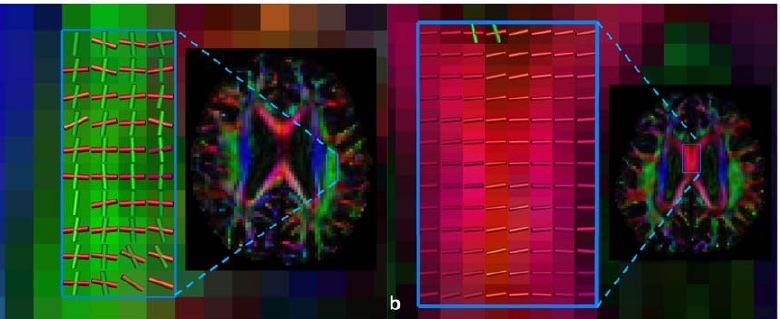
Figure 3. Fiber orientation distribution profiles estimated with the CSD method. a) two crossing fiber populations in voxels in the superior longitudinal fasciculus. b) one fiber population in the corpus callosum.